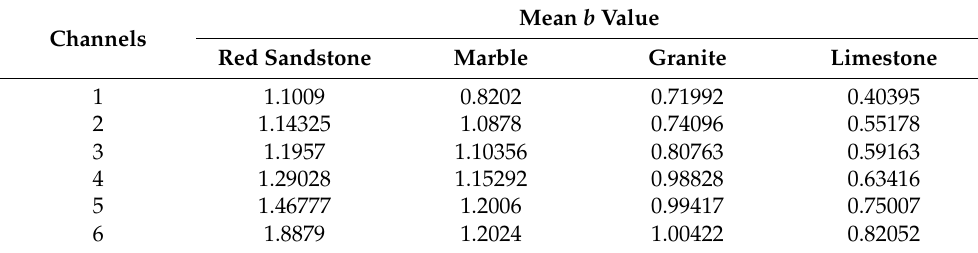
Table 3. b values of 6 channels of red sandstone, marble, granite, and limestone.